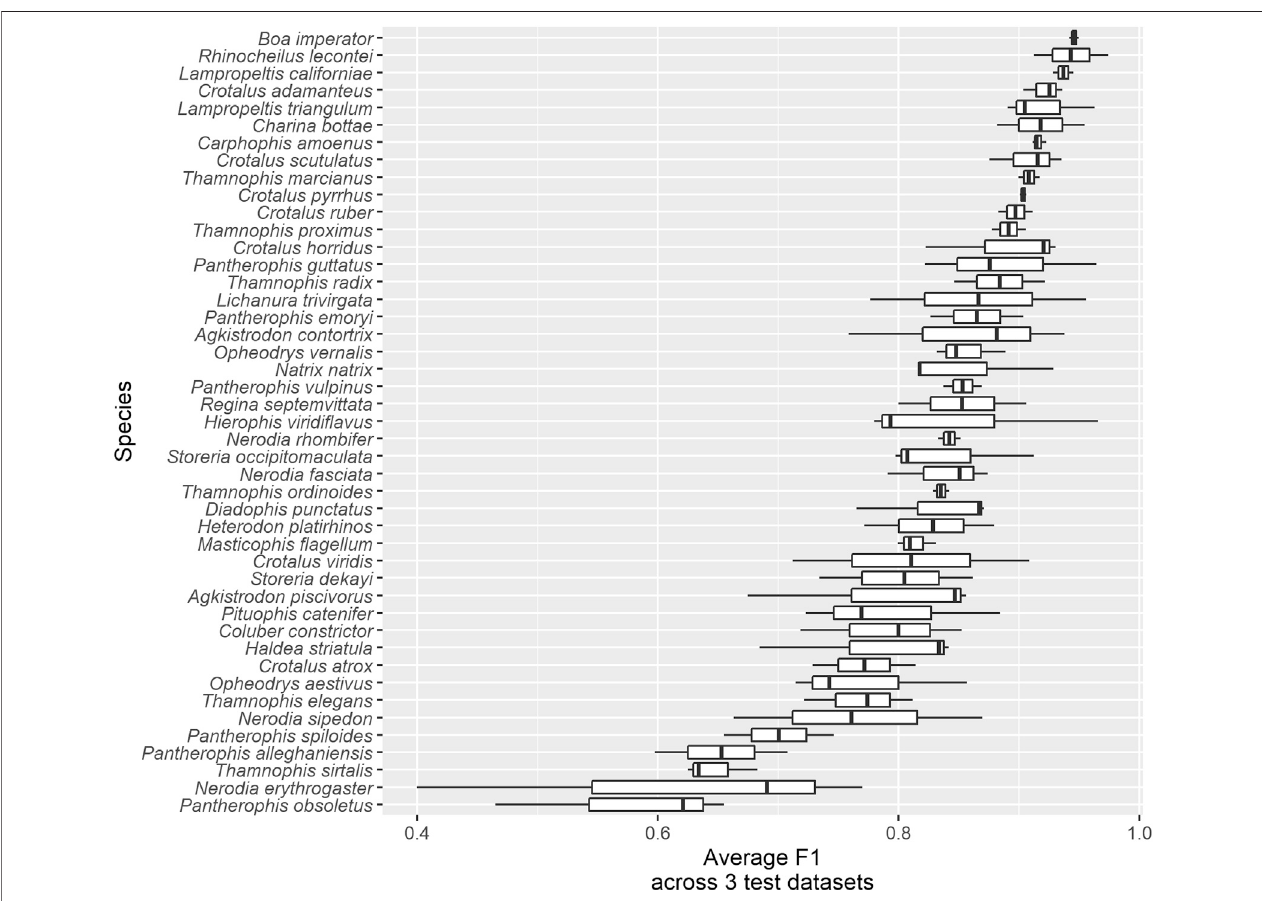
FIGURE 6 | Average F1 across three test datasets for all 45